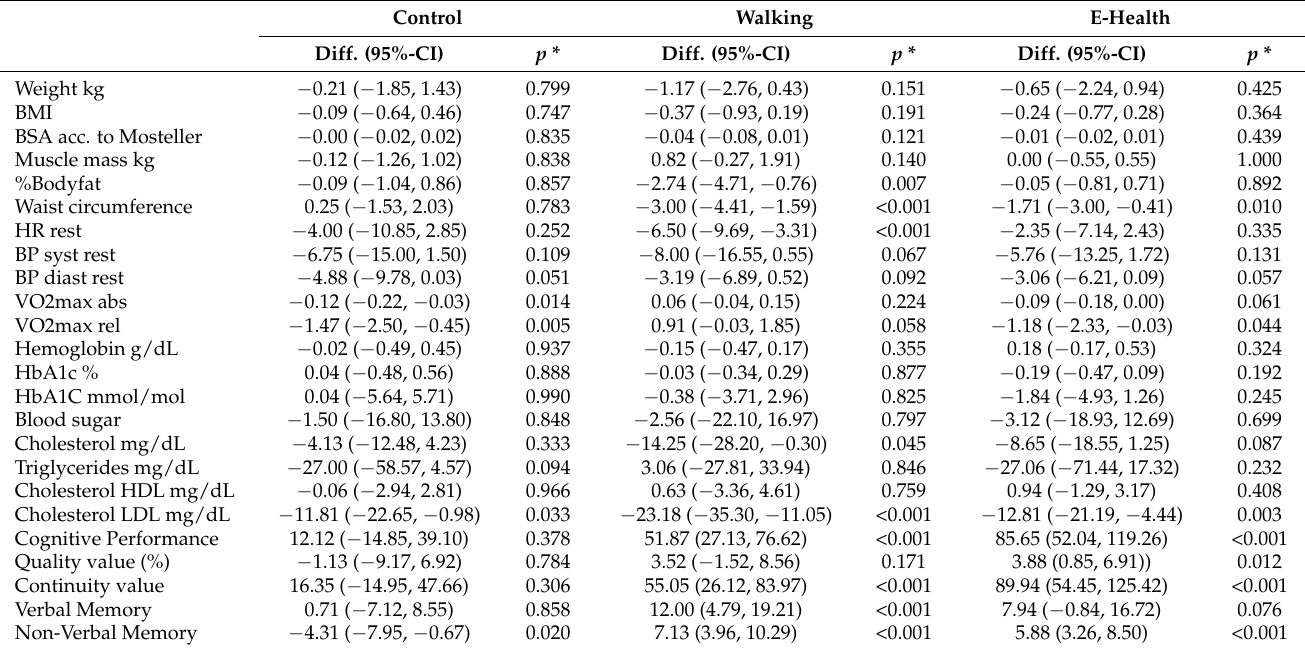
Table 2. Calculated differences and confidence interval. p * sigificant p <